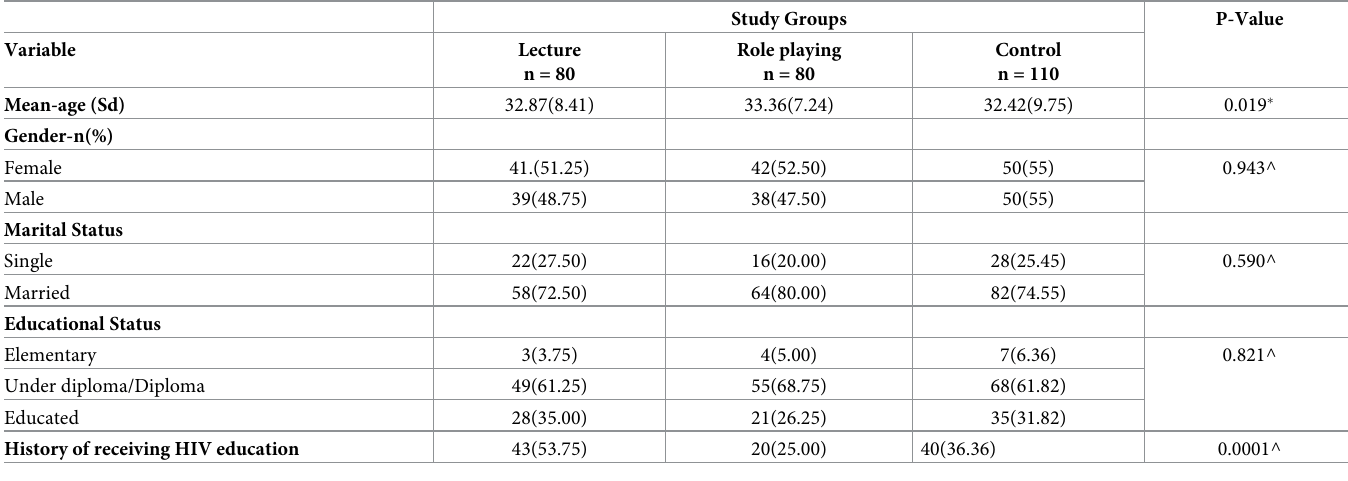
Table 1. Demographic characteristics of the participants.